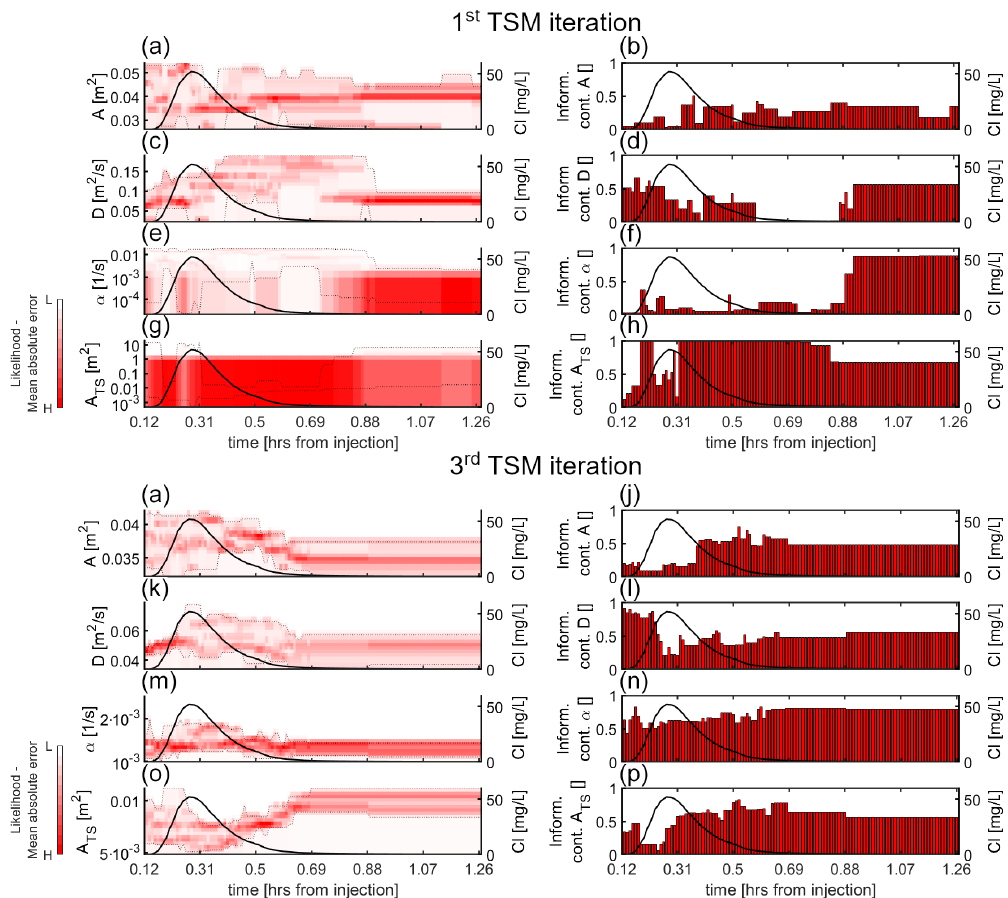
Figure 5. Same as Fig. 4 but reporting dynamic identifiability results for E1 when v was set equal to v peak